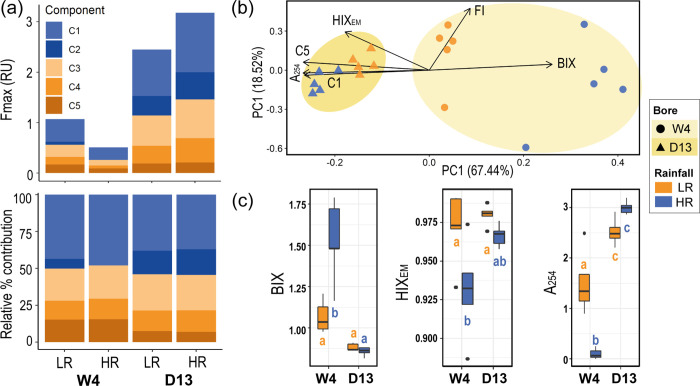
CDOM characterisation between bores and recharge periods.(a) Fluorescence maximum in Raman units (Fmax) and percent contribution of the five PARAFAC components (i.e. C1, C2, C3, C4 and C5), (b) PCoA ordination discriminating PARAFAC components, fluorescence indices (HIXEM, BIX) and absorbance indices (A254) where correlations of indices with axes are visualised as arrows, and, (c) BIX, HIXEM, and A254 values. Significant post hoc comparisons (P < 0.05) are indicated by lowercase letters.